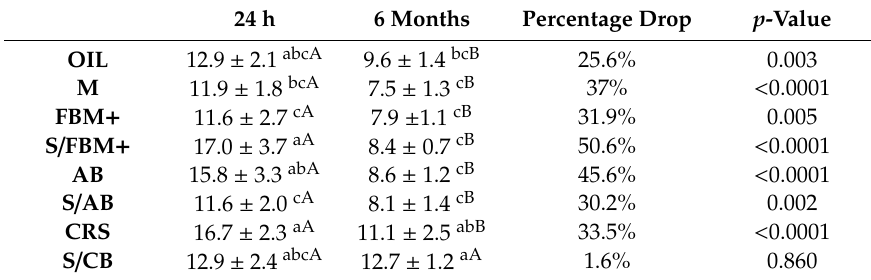
Table 3. Mean ± standard deviation of µ SBS in MPa for the e ff ect surface treatment within each storage time, and the e ff ect of storage time within each surface treatment; and percentage drop in µ SBS of Admira Fusion X-tra resin composite.